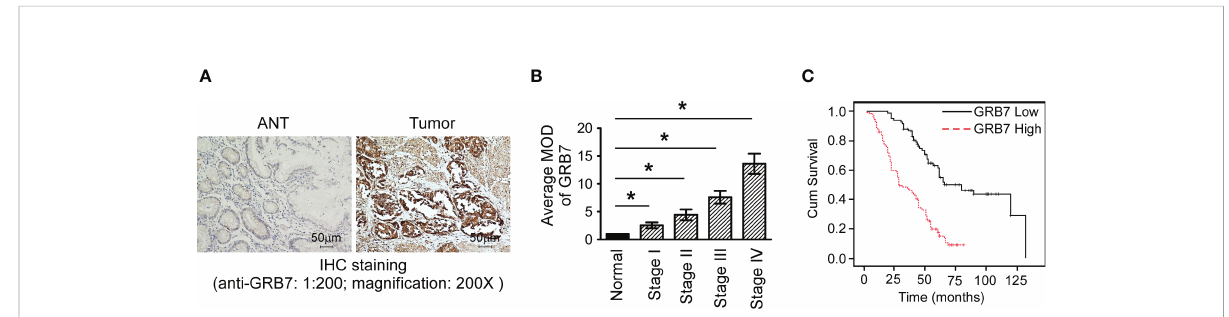
FIGURE 2 The expression of GRB7 protein in immunohistochemistry was related to the clinical features of gastric cancer. (A) Typical photos of a paraf fi n section showed that the expression of GRB7 protein in cancer tissues was signi fi cantly higher than that in normal gastric tissues. (B) Statistical quanti fi cation of mean optical density (MOD) based on different clinical grades of gastric cancer showed that GRB7 protein expression increases with the clinical stage. The value of each stage was compared with the mean value of GRB7 staining of non-cancerous tissues. *P<0.05. (C) Kaplan-Meier curve showed that the prognosis of gastric cancer patients in the GRB7 high expression group was